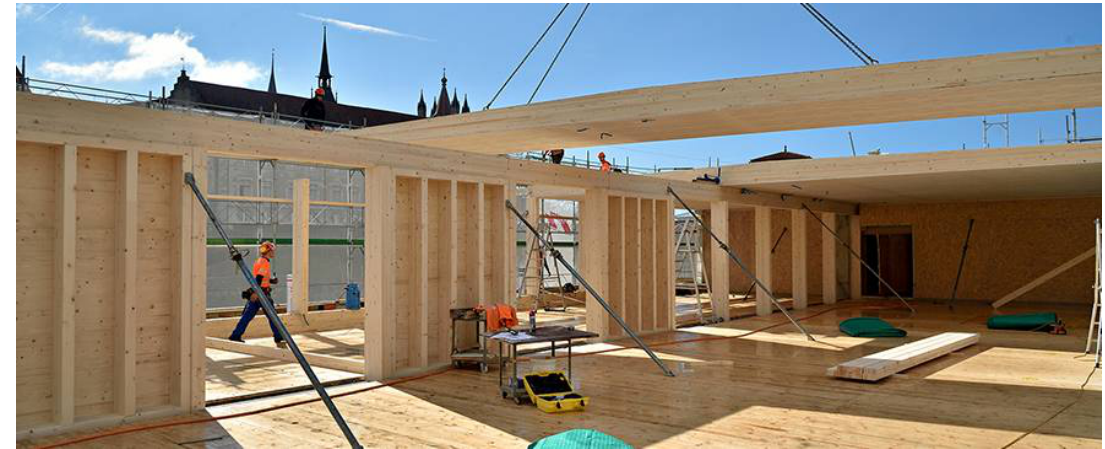
Figure 8. On-site assembly of the prefabricated wooden elements.